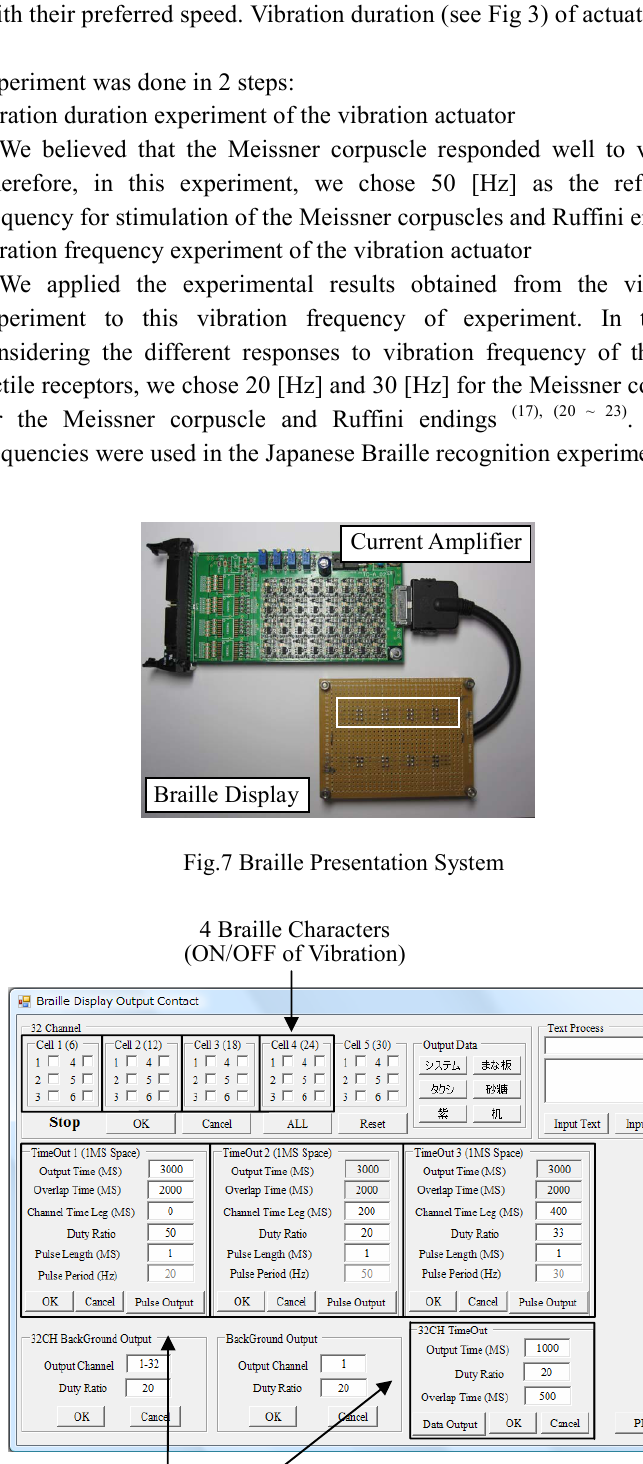
Fig.8 Dialog Interface for Parameter Settings